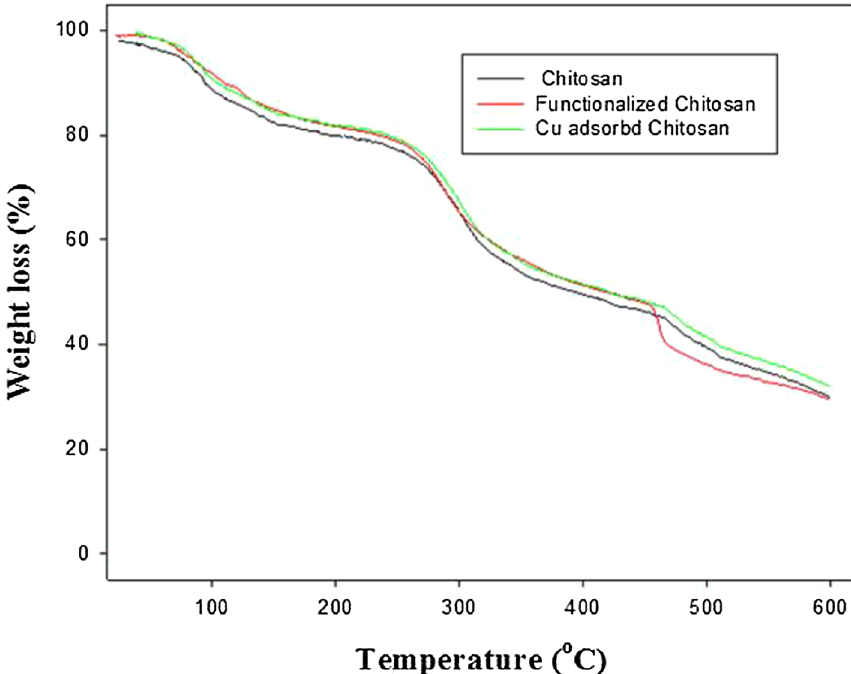
Fig. 6 TGA curves of chitosan, cross-linked chitosan and Co/ cross-linked